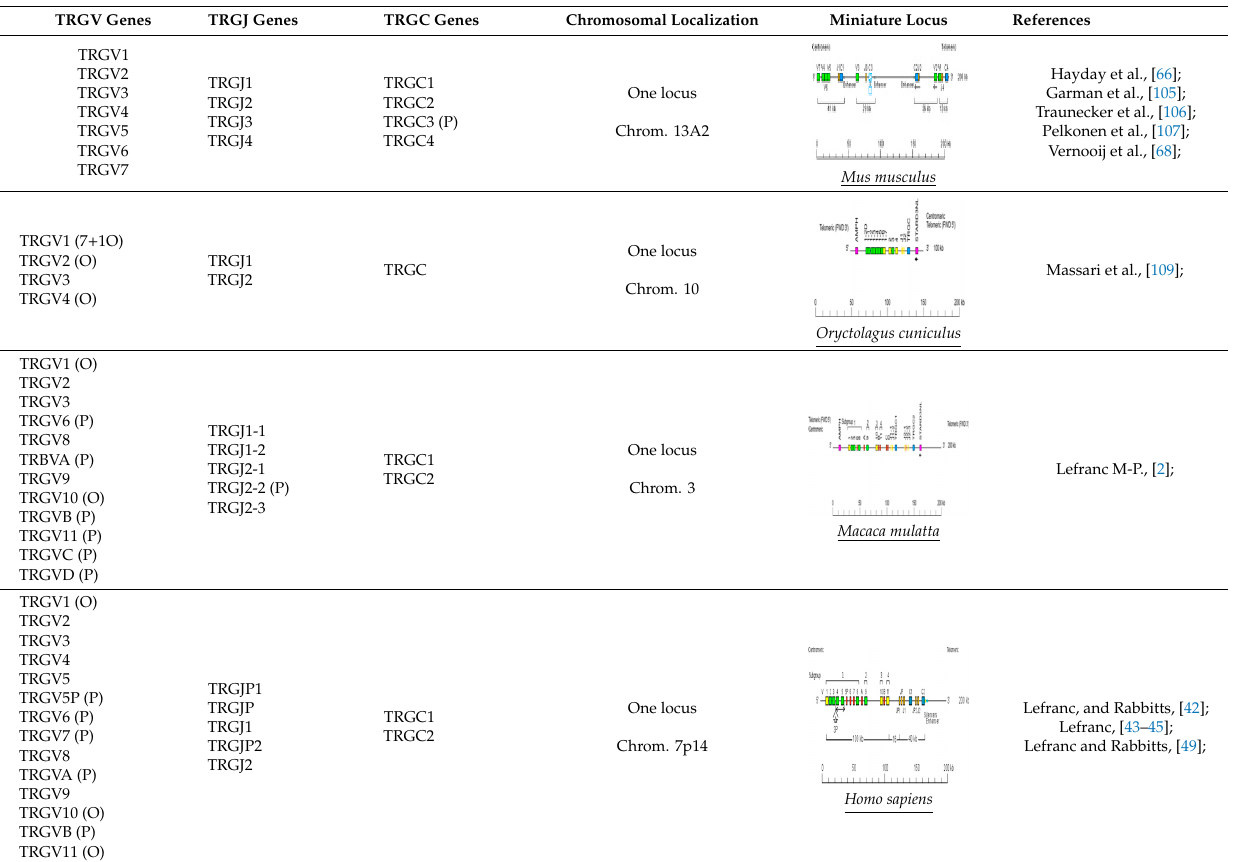
Table 4. Genomic organization and gene content of the TRG locus in Rodentia, Lagomorpha and Primata.